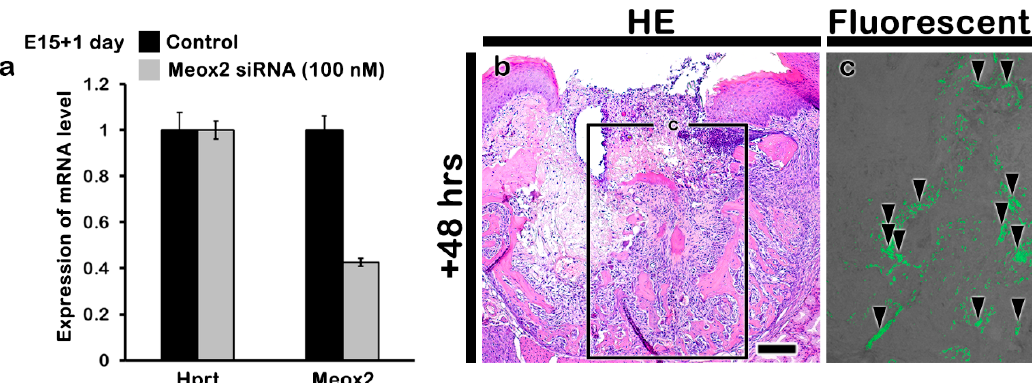
Figure 2. RT-qPCR evaluation of expression pattern of si Meox2 after 1 day using hanging-drop cultivation with tooth germ together posterior palate at E15 ( a ). Local delivery of siRNA into tooth loss lesion using green fluorescent protein (GFP) expression ( b , c ). Black arrowheads in c indicate GFP positive fluorescent reactions.